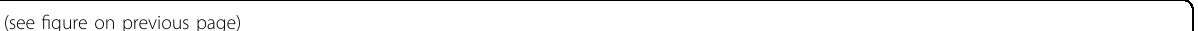
Fig. 1 Single cell RNA-seq pro fi ling and unbiased clustering of cells from full thickness human uterine tissues. a Work fl ow shows sample processing, enzymatic digestion and drop-seq based single cell RNA-seq. b UMAP plot of 6 main clusters, donor ID and secretory/proliferative origin phases of full-thickness uterus by single cell RNA-seq (scRNA-seq). c Heatmap shows speci fi cally expressed gene signature of the 6 main clusters of full-thickness uterus. d Gene ontology (GO) analysis of the speci fi cally expressed gene signature of the 6 main clusters of full-thickness uterus. e Violin plot showed speci fi c marker genes from gene signatures of each cell cluster (DES, CNN1 for myometrial smooth muscle cells; COL1A1, ECM1 for stroma cells; KRT8, EPCAM for epithelial cell; CLDN5, VWF for endothelial cells; ADIRF, CRIP1 for vascular smooth muscle cells; PTPRC, CD68 for immune cells). f Immunohistochemistry staining from the HPA further validated the expression of speci fi c markers of the 6 main clusters: COL1A1 (https://www.proteinatlas.org/ENSG00000108821-COL1A1/tissue/endometrium#img), ECM1 (https://www.proteinatlas.org/ENSG00000143369-ECM1/ tissue/endometrium#img) was expressed in the uterus stromal cells, DES (https://www.proteinatlas.org/ENSG00000175084-DES/tissue/ endometrium#img) was expressed in the uterine myometrial smooth muscle cells, ADIRF (https://www.proteinatlas.org/ENSG00000148671-ADIRF/ tissue/endometrium#img) was expressed in the uterine vascular smooth muscle cells, CLDN5 (https://www.proteinatlas.org/ENSG00000184113- CLDN5/tissue/endometrium#img), VWF (https://www.proteinatlas.org/ENSG00000110799-VWF/tissue/endometrium#img) were expressed in the uterus endothelial cells, EPCAM (https://www.proteinatlas.org/ENSG00000119888-EPCAM/tissue/endometrium#img), KRT8 (https:// www.proteinatlas.org/ENSG00000170421-KRT8/tissue/endometrium#img) were expressed in the uterus epithelial cells,, PTPRC (https:// www.proteinatlas.org/ENSG00000081237-PTPRC/tissue/endometrium#img), CD68 (https://www.proteinatlas.org/ENSG00000129226-CD68/tissue/ endometrium#img) were expressed in the uterus immune cells. Scale bar, 25